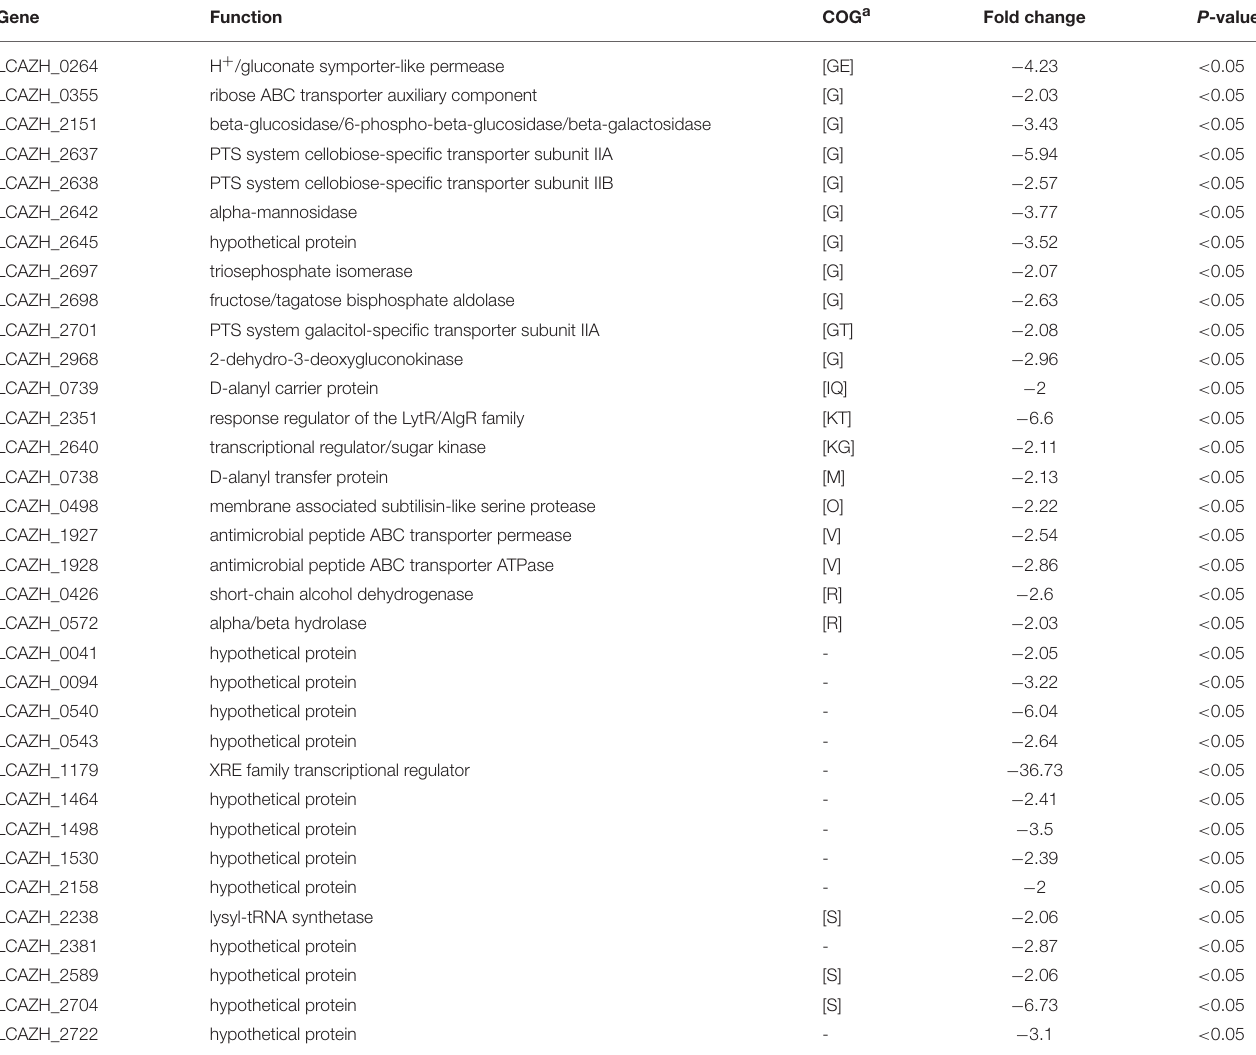
TABLE 3 | Down-regulated Lactobacillus casei Zhang-A-600 proteins in comparison with the parental strain. Gene Function COG a Fold change P -value